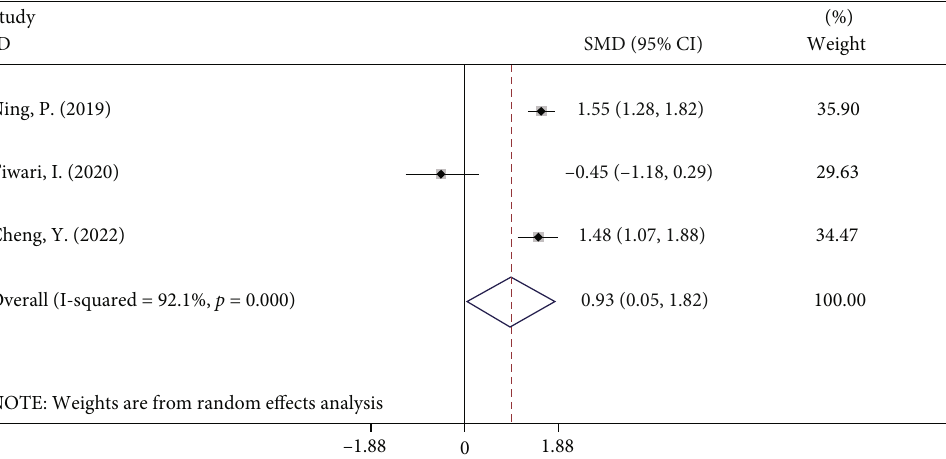
Figure 9: Meta-analysis of di ff erences in NLR levels between GBS patients who underwent mechanical ventilation and those who did not.